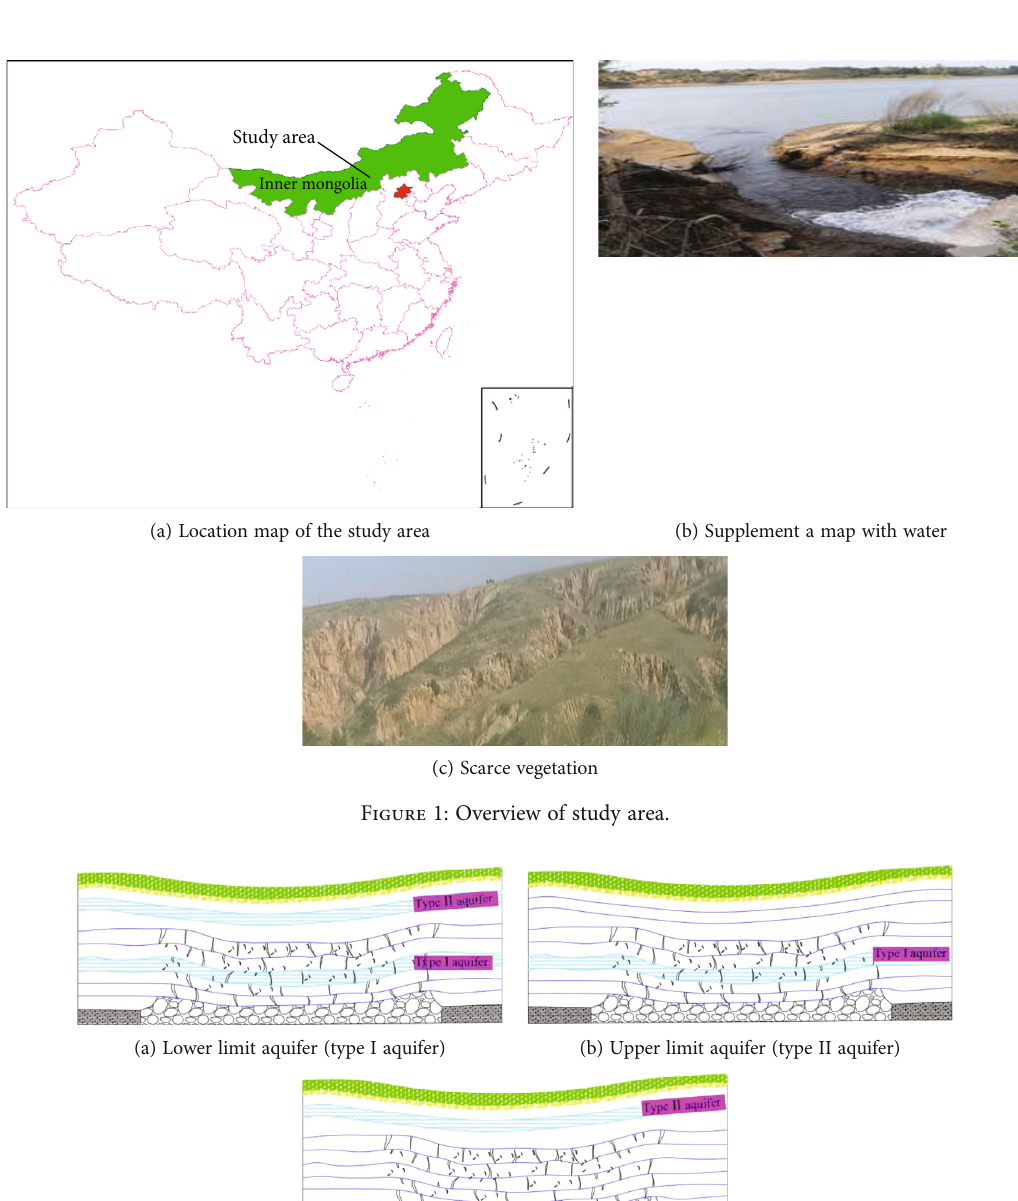
Figure 2: Generalized classi fi cation of coal-water occurrence relationship in shallow coal